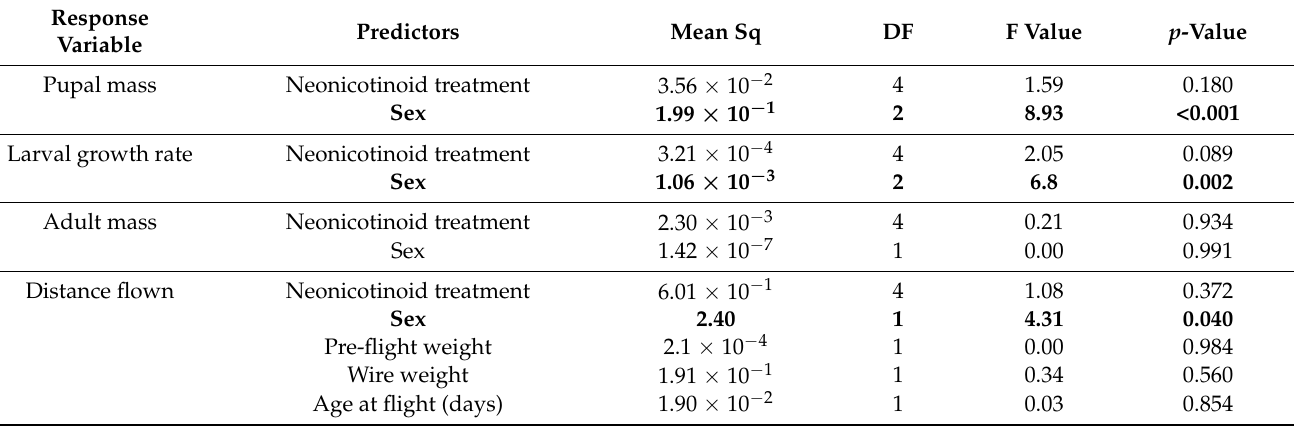
Table 2. Results of general linear models investigating predictors of monarch development and flight in Experiment 1. Monarch lineage was included as a random effect in all models. Neonicotinoid treatment was included as a fixed factor with 5 levels as described in the Methods section. Significant variables appear in